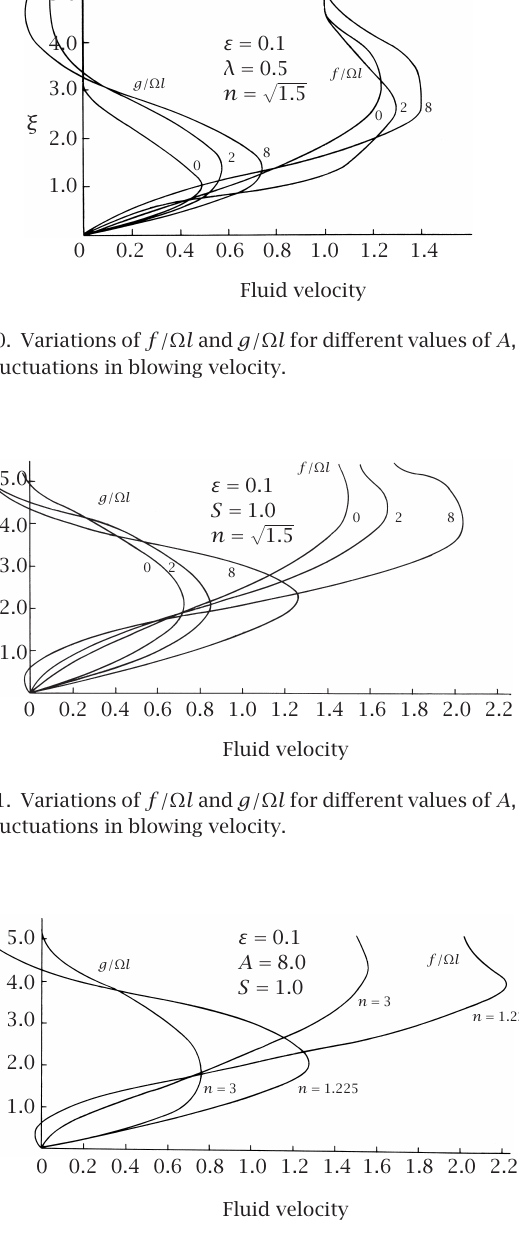
Figure 3.12 . Variation of f/ Ω l and g/ Ω l with n , the frequency of fluctua- tions of the blowing